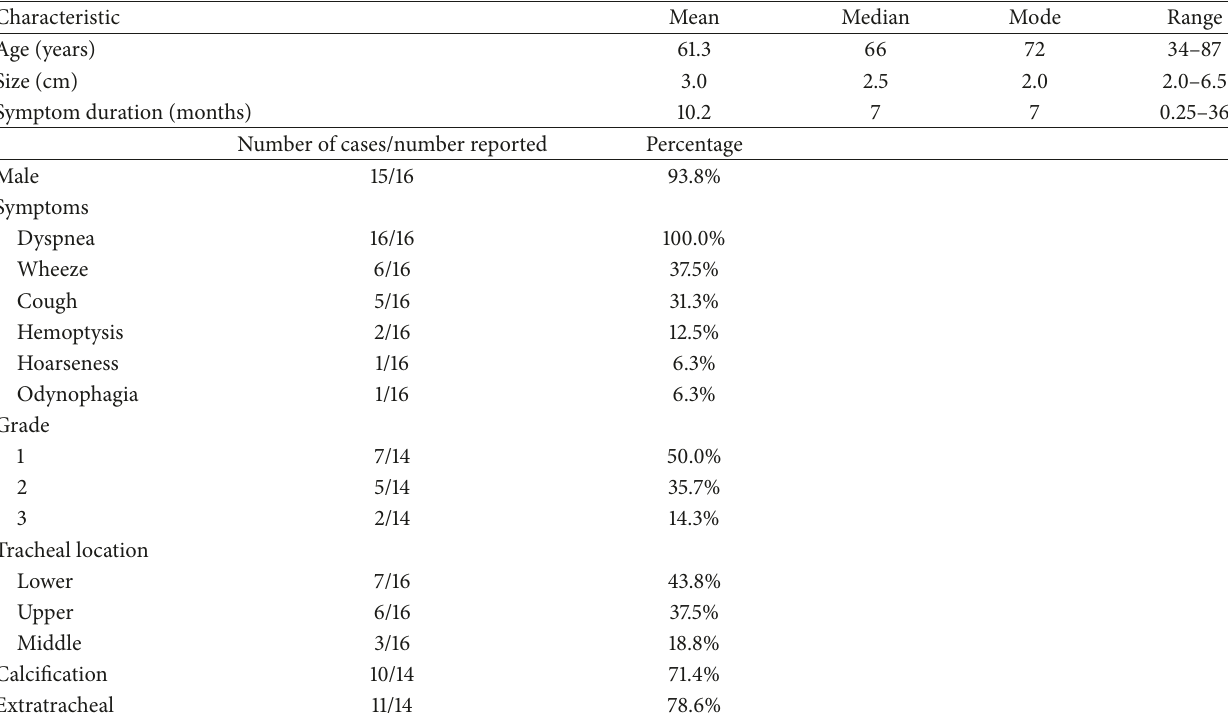
Table 2: Analysis of selected characteristics of tracheal chondrosarcoma